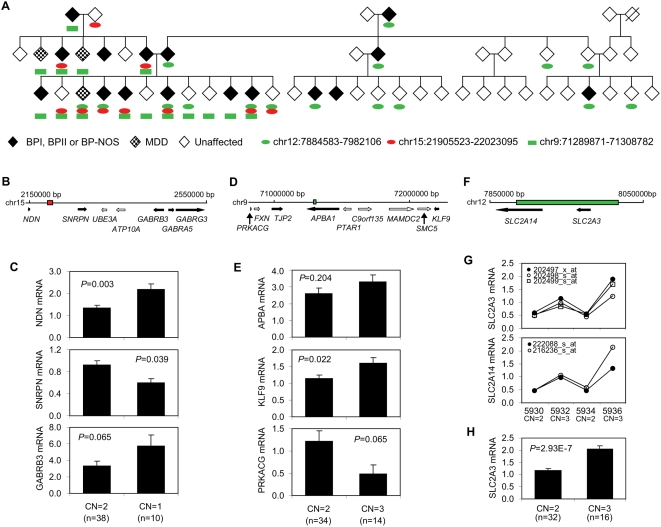
CNVs frequently found in affected subjects were associated with changes in gene expression.(A) The distribution of three CNVs in members of the Amish family 884. Ovals or bars below a subject indicate the presence of CNVs in that individual. Green indicates duplication by one copy, red indicates deletion by one copy. (B) Diagram of the locus of a CNV region (indicated by the red bar) in chr15 showing surrounding genes. Black arrows indicate genes examined in this study. (C) The CNV in chr15 was associated with altered expression of genes NDN (upper panel), SNRPN (middle panel), and GABRB3 (lower panel). (D) Diagram of the locus of a CNV region (green bar) in chr9 located in the second intron of APBA1 gene. Black arrows indicate examined genes. (E) The CNV in chr9 does not affect the expression of APBA1 gene (upper panel), but it was associated with altered expression of KLF9 (middle panel) and PRKACG (lower panel). (F) Diagram of the locus of a CNV region (green bar) in chr12 containing gene SLC2A3 and partially containing SLC2A14. (G) The expression levels of SLC2A3 (top panels) and SLC2A14 (lower panels) in LCLs of four individuals (GM05930, GM05932, GM05934, GM05936). Plotted are normalized data from microarray analysis for two or three probes. (H) The expression level of SLC2A3 in 48 fibroblast samples from Amish family 884. CN, copy number. Data are mean±SE; P values were from t-test.